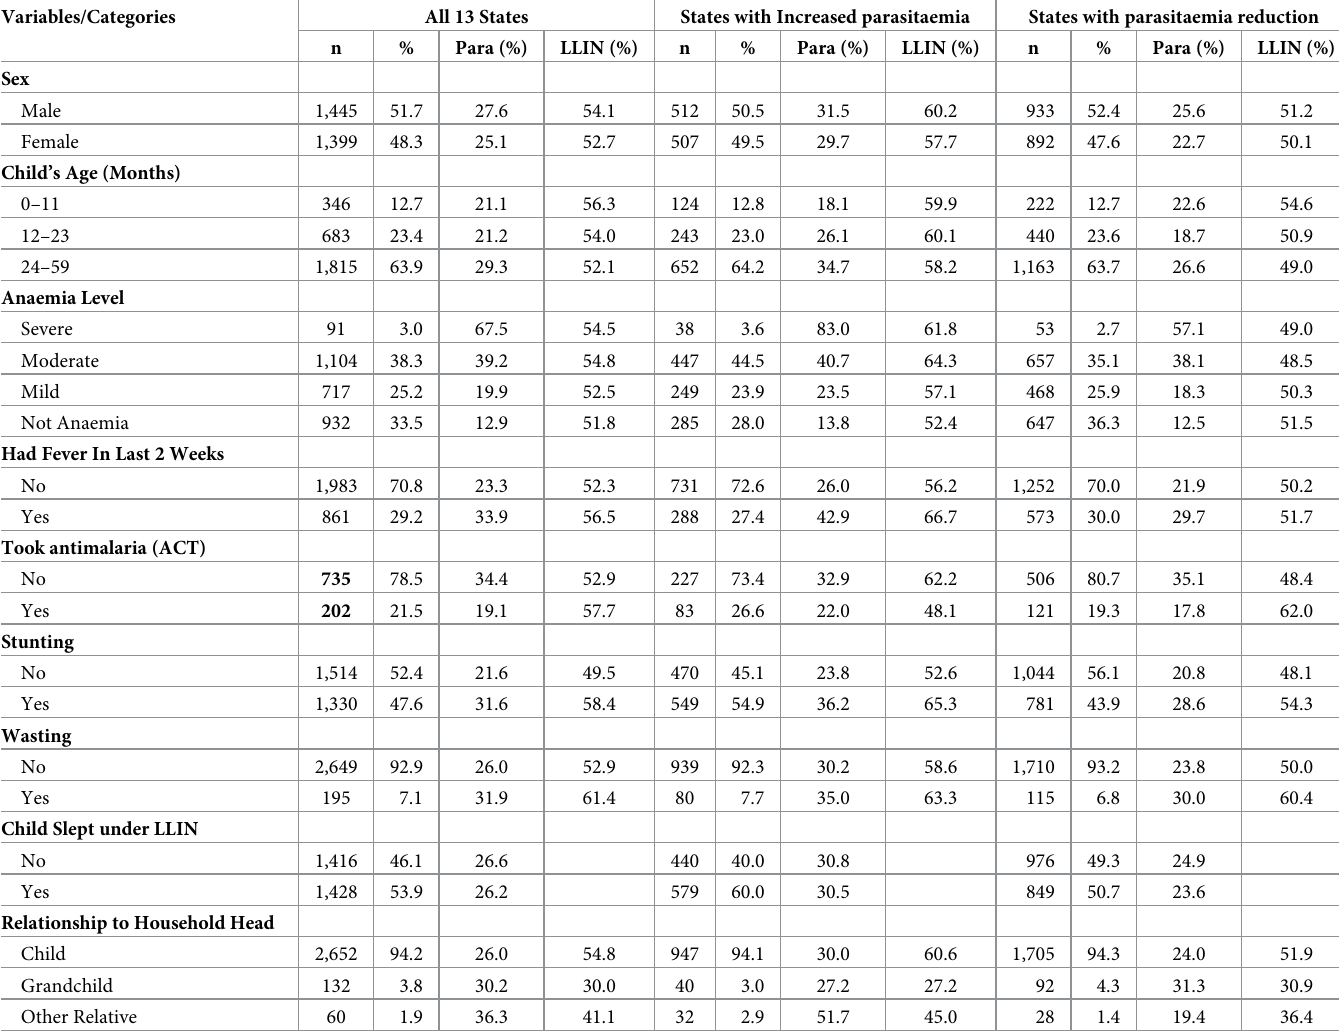
Table 2. Distribution of the children characteristics in the study States, NDHS